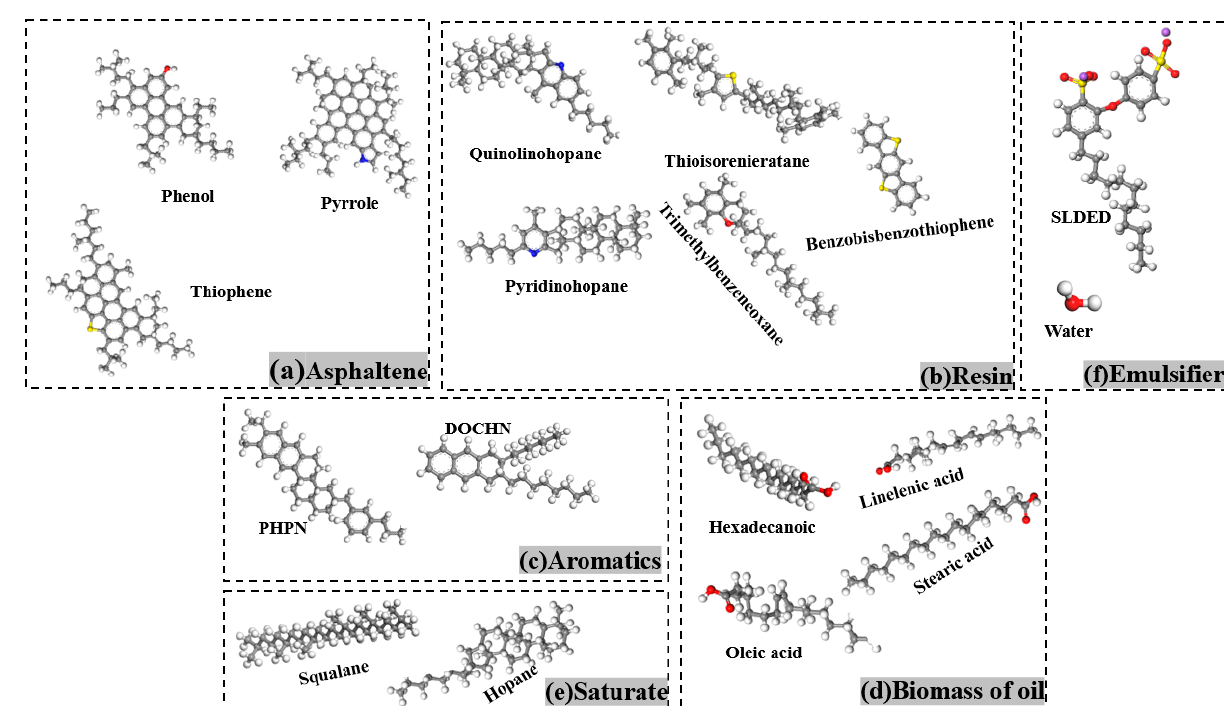
Figure 1. Composition diagram of bio-oil asphalt/water emulsion model.